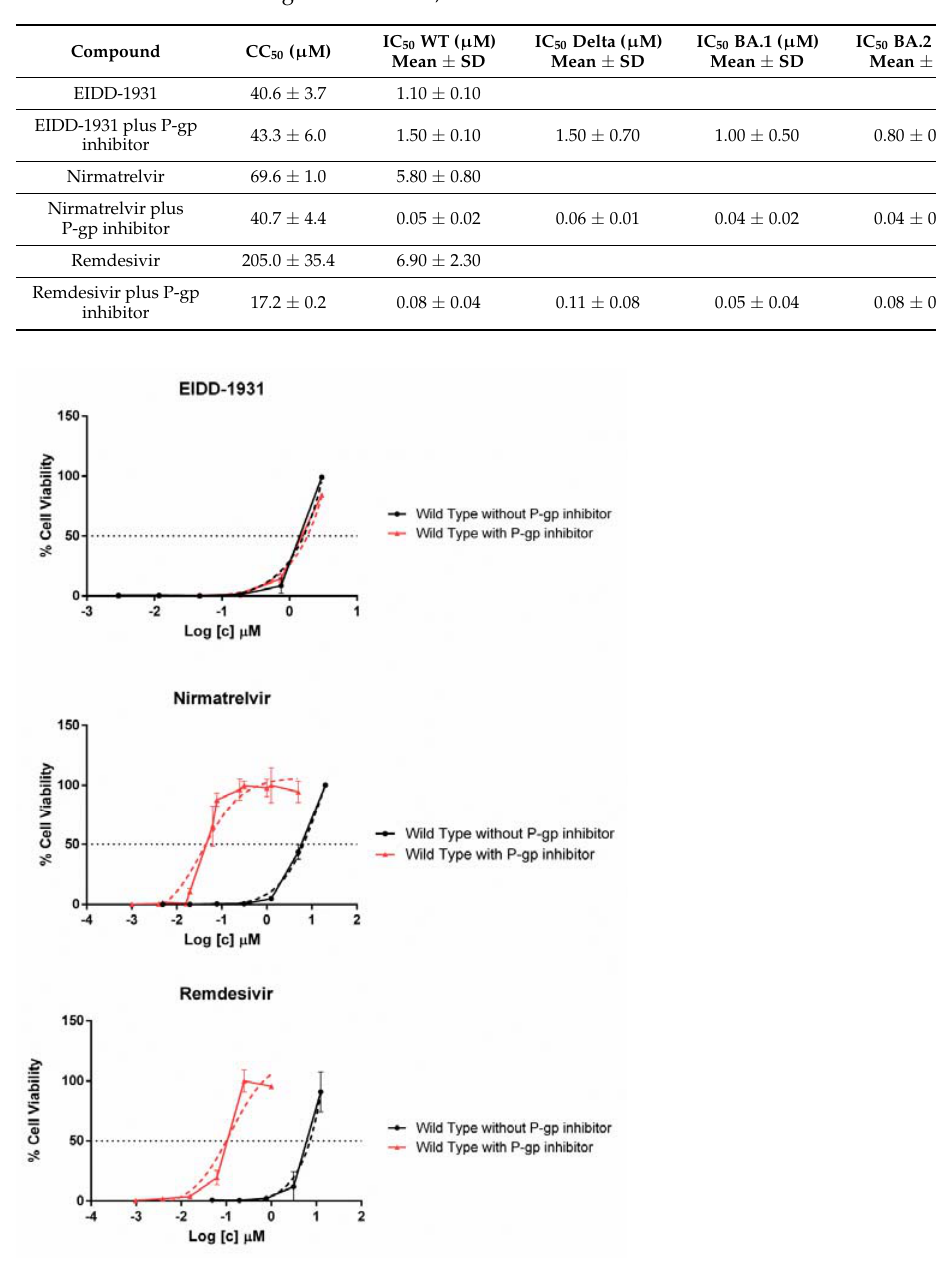
Table 1. Anti-SARS-CoV-2 activity of EIDD-1931 (the active form of molnupiravir), remdesivir and nirmatrelvir in VERO E6 cells. Compounds were tested in absence of P-gp inhibitor (CP-100356 hydrochloride) against wild-type strain and in presence of 0.5 µ M P-gp inhibitor against Wild Type (WT), Delta, BA.1, and BA.2 variants. CC 50 : half-maximal toxic drug concentration; IC 50 : half-maximal inhibitor drug concentration; SD: Standard Deviation.